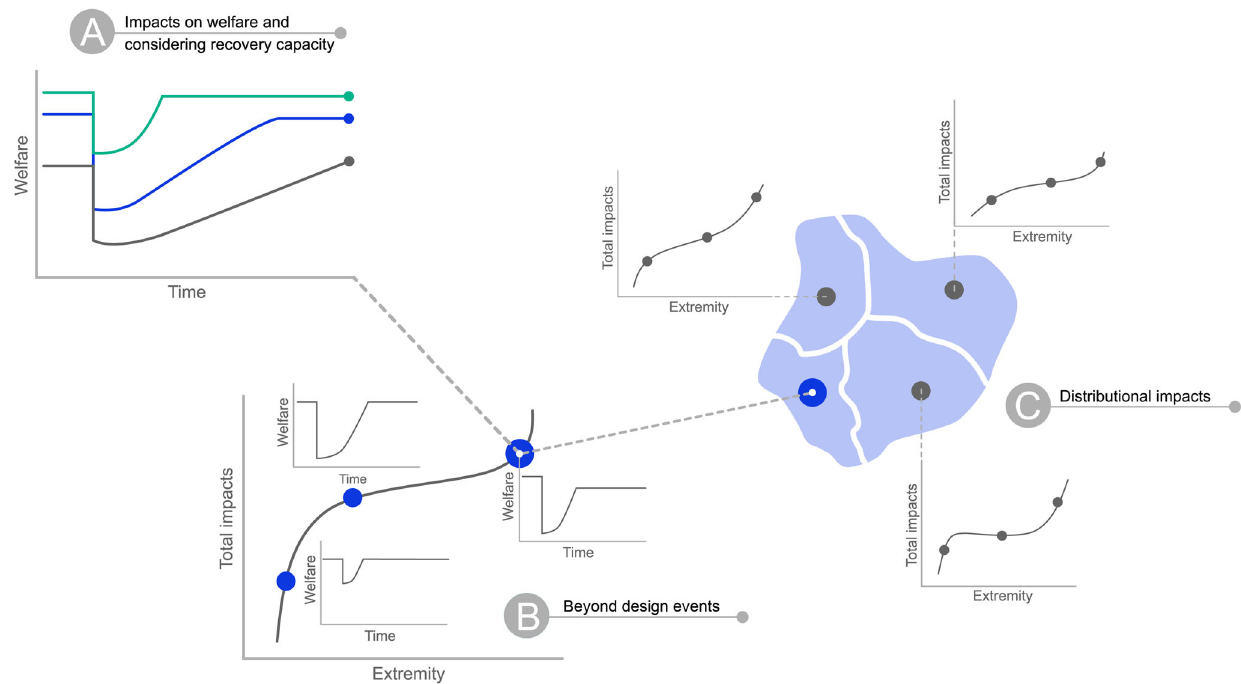
Fig. 1 Adopting a resilience lens by operationalizing the four elements into an integrated fl ood risk management approach. A welfare and recovery capacity (element 1 and 2): Different effects of fl oods on different areas or societal groups: some have a larger deterioration of welfare or a slower recovery than others. Both the maximum impact and the recovery together determine the impact of a fl ood disaster. B include beyond-design events (element 3). The grey curve shows the impacts as a function of event extremity. The standard assessment integrates over this curve and uses the resulting expected annual damage as risk measure; this aggregation undermines the role of high-impact but low-probability events. The extreme events must be given attention as well; ( C ) distributional impacts (element 4). Distributional impacts can be considered spatially or for different social groups. Welfare economics principles can be applied to capture the utility of different communities and vulnerable groups. By aggregating the effects, we may not see how some groups bene fi t from measures while others pay for them, or still face large risks. Therefore, next to total cost and bene fi ts, also distributed impacts must be used and weighted to enhance